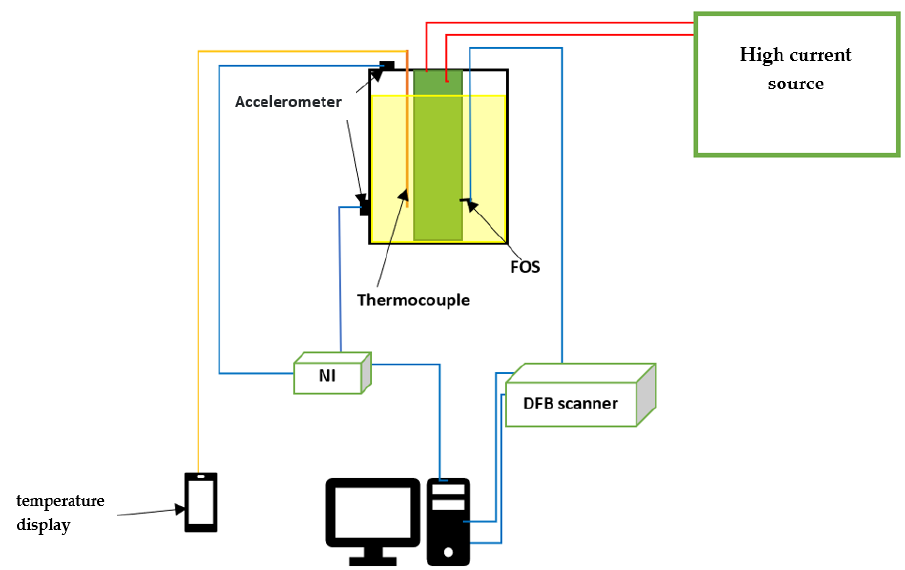
Figure 10. Schematic of the experimental setup (FOS: Fiber optic Sensor).